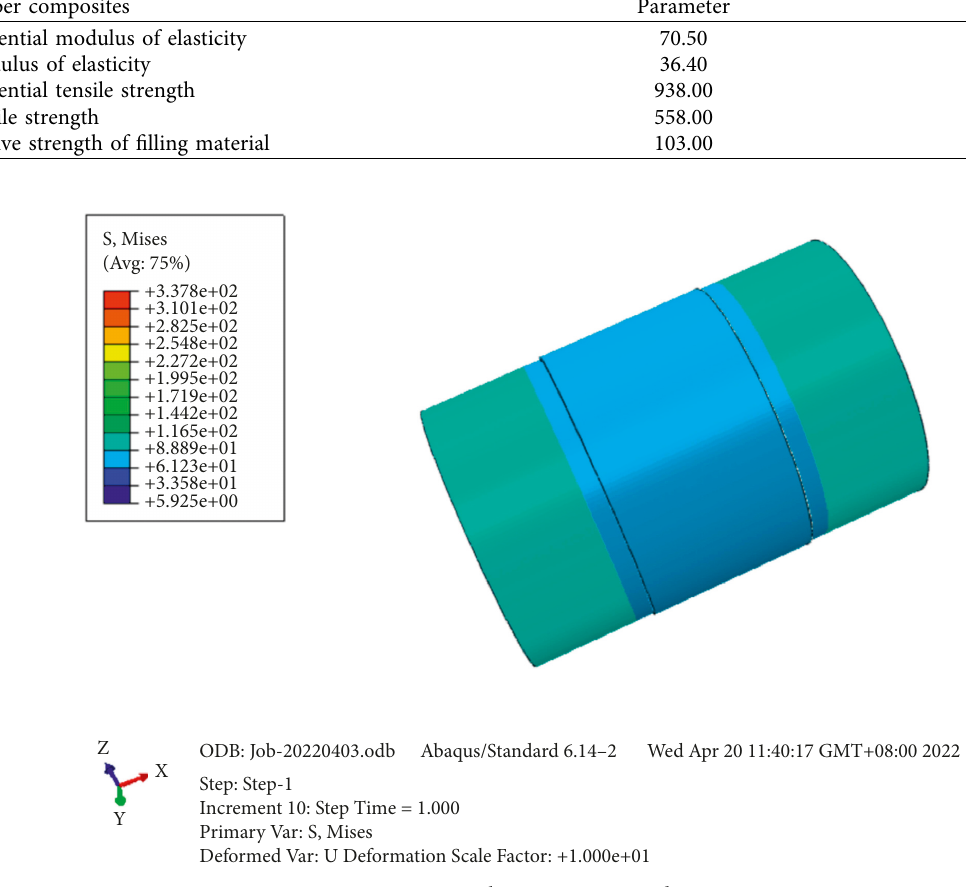
Figure 12: B -type sleeve repair stress